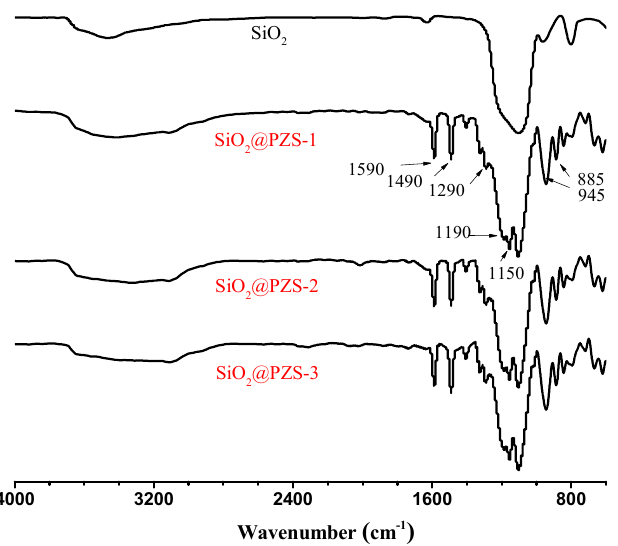
Figure 2. FT-IR spectra of SiO 2 , SiO 2 @PZS−1, SiO 2 @PZS−2 and SiO 2 @PZS−3.